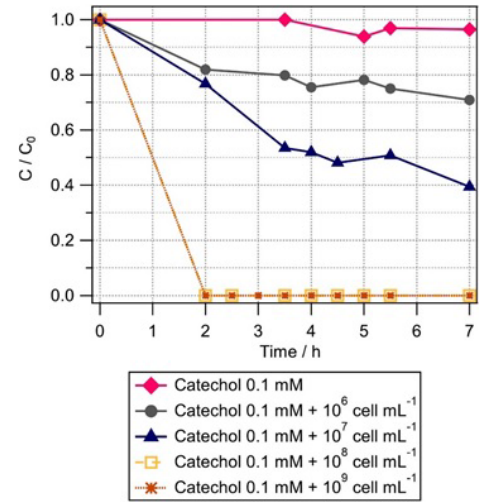
centrations of Rhodococcus enclensis : 10 9 cellmL − 1 (brown stars), 10 8 cellmL − 1 (brown squares), 10 7 cellmL − 1 (blue triangles), and 10 6 cellmL − 1 (black circles). C : phenol concentration at time t ; C 0 : initial phenol concentration. C/C 0 was extrapolated from the ratio of the integrals of the catechol signal m/z = 110 . 03678 de- tected in mass spectra at time t = 0 and t , respectively. Initial cate- chol concentration was